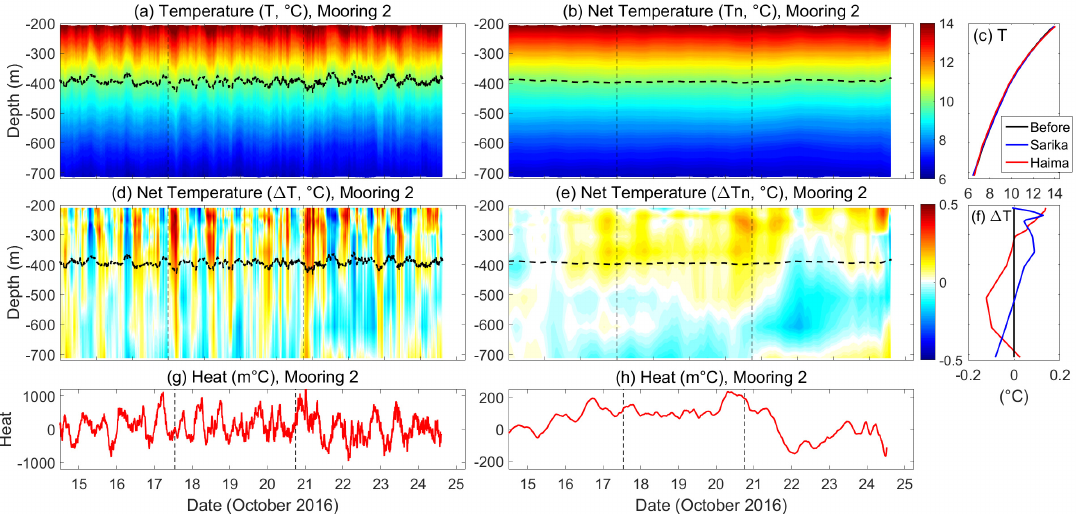
Figure 10. Mooring 2 parameters corresponding to those in Figure 9. The heat content anomaly and net heat content anomaly in ( g – h ) are between 210 m to 500 m in the observation (red